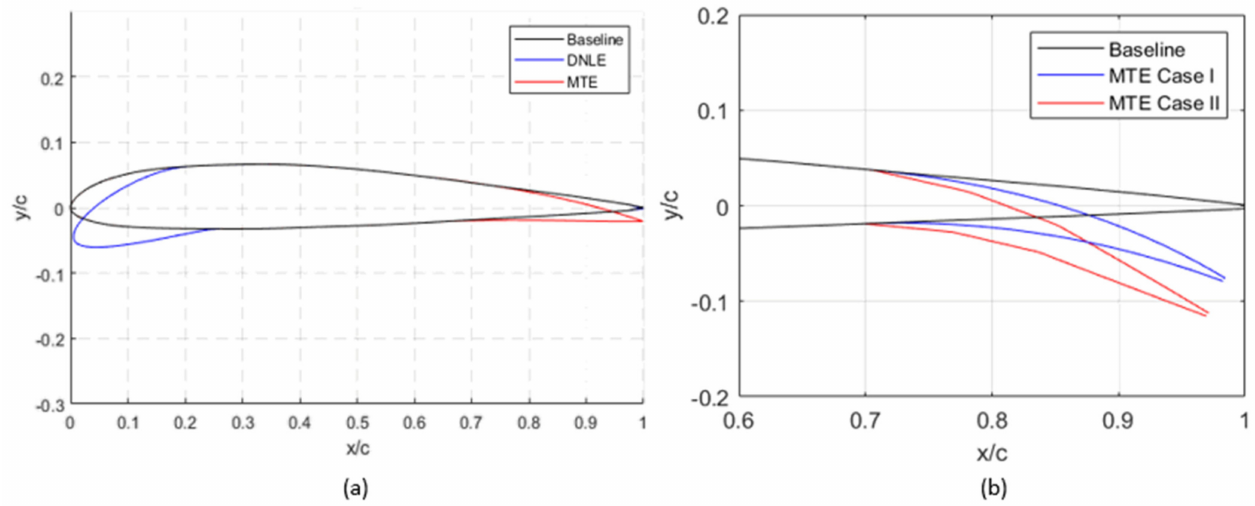
Figure 7. Design of Droop Nose Leading Edge (DNLE) and Morphing Trailing Edge (MTE) airfoil configurations versus the baseline airfoil. ( a ) the basic concept of the morphing wing with combined morphing leading and trailing edge deflections; ( b )the two cases of MTE designs.